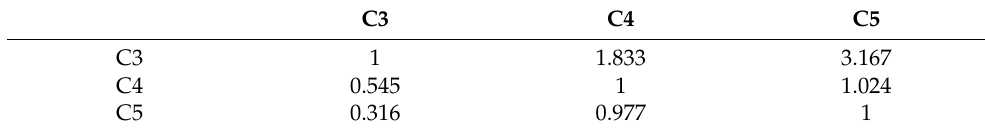
Table 8. C3–C5 importance judgment matrix.